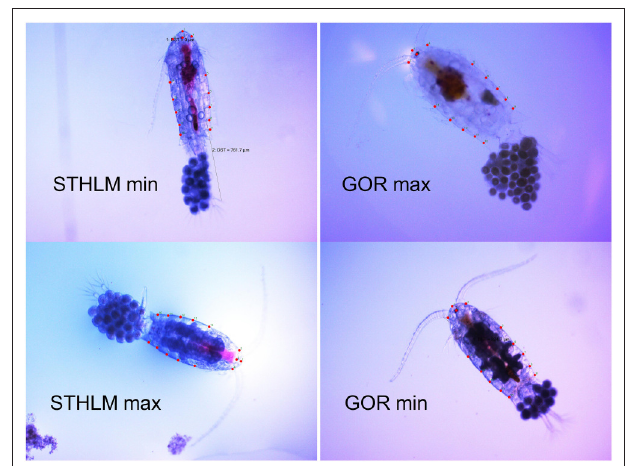
FIGURE 2 | Pictures of E. affinis individuals with minimum and maximum value on principal component 1 from the respective population, these individuals are marked out in Figure 1 . Pictures include locations of the 14 landmarks used in the principal component analysis. The prosome lengths of the individuals depicted are 833 and 776 µ m for STHLM min and max, and 833 and 923 µ m for GOR min and max, respectively. Note that the pictures are meant to show variation in shape and not in size and length. The scale of the pictures are 2,300 µ m wide and 1,725 µ m high.